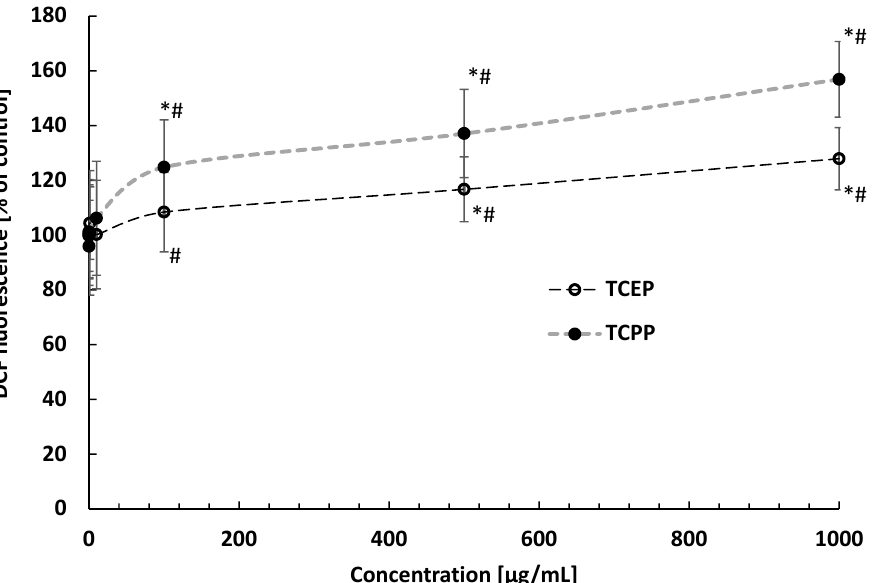
Figure 7. Changes in total ROS level in control erythrocytes and erythrocytes incubated with TCEP and TCPP at concen- trations ranging from 0.001 to 1000 μ g/mL for 24 h. * p < 0.05 indicates statistically significant difference from control; (#) statistically significant difference between TCPP and TCEP, one-way ANOVA, and a posteriori Tukey test.